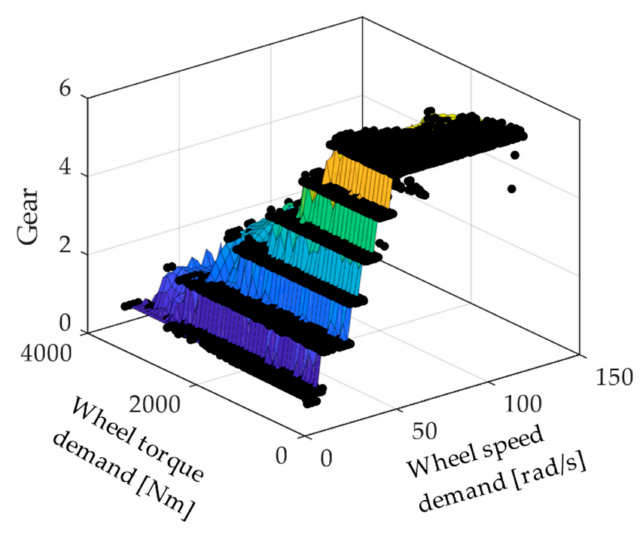
Figure 1. Static gear shift map.